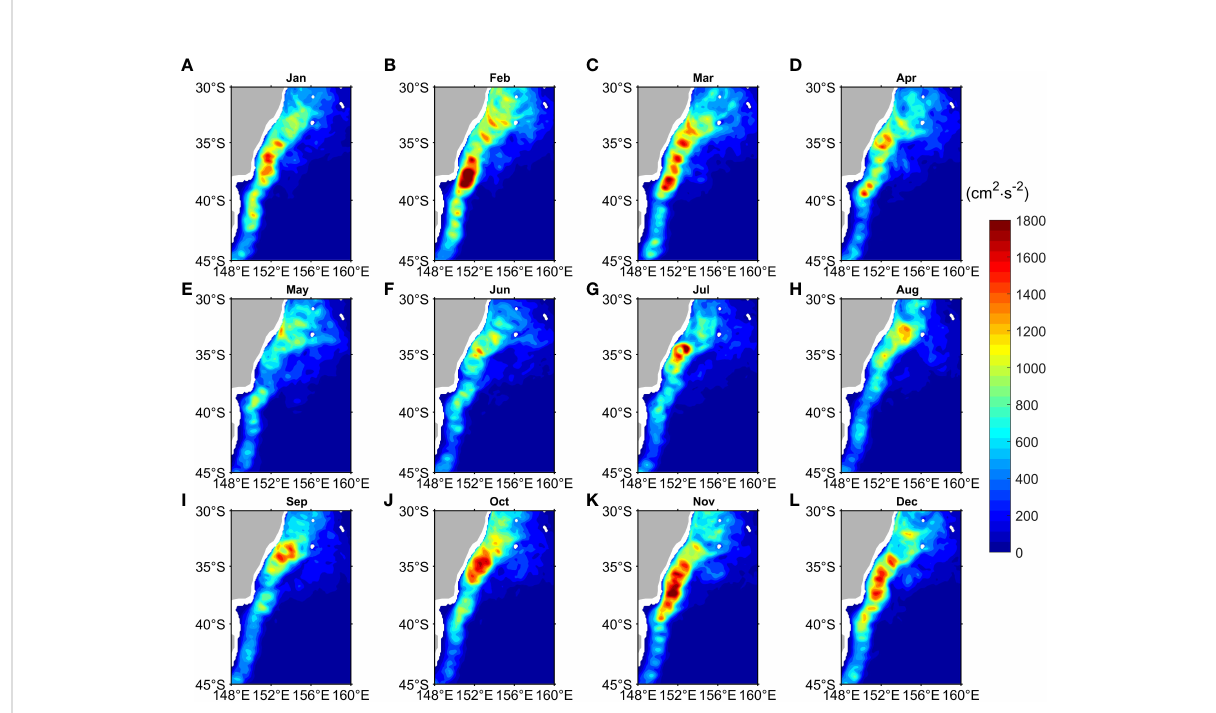
FIGURE 5 Monthly mean EKE distribution averaged over the upper 300 m layer from OFES during July 1999-October 2009 for (A) January, (B) February, (C) March, (D) April, (E) May, (F) June, (G) July, (H) August, (I) September, (J) October, (K) November and (L)